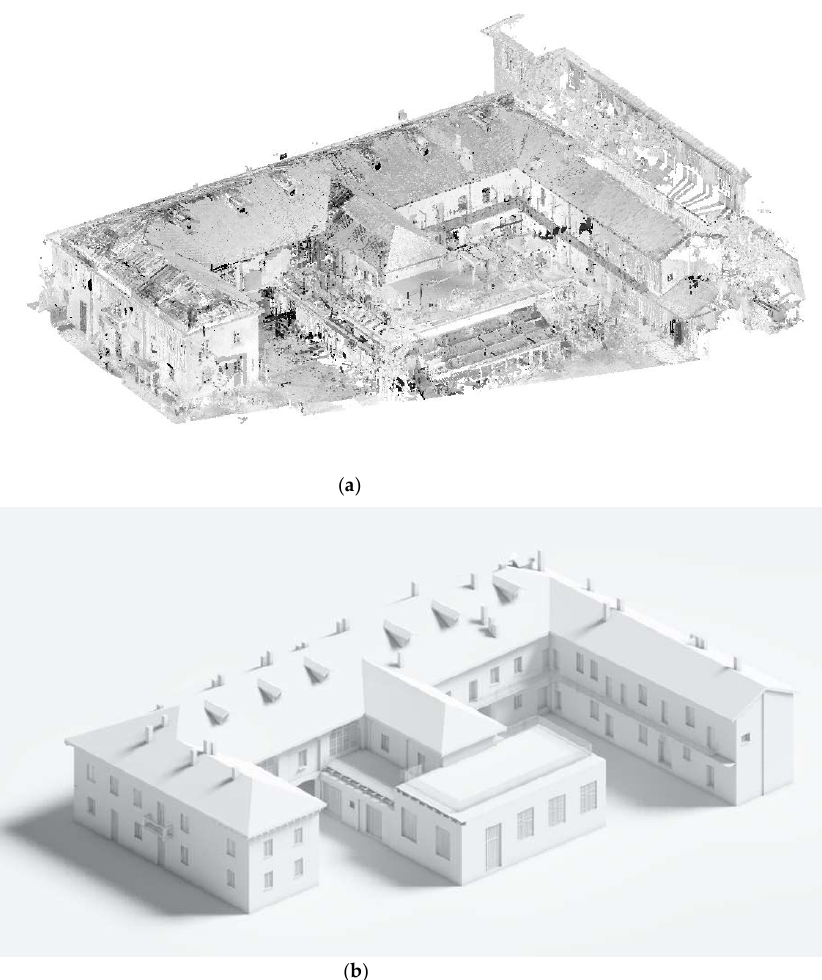
Figure 8. Reconstruction of the parametric 3D model and photorealistic representation of the white-model render: ( a ) point cloud, ( b ) re-drawing.